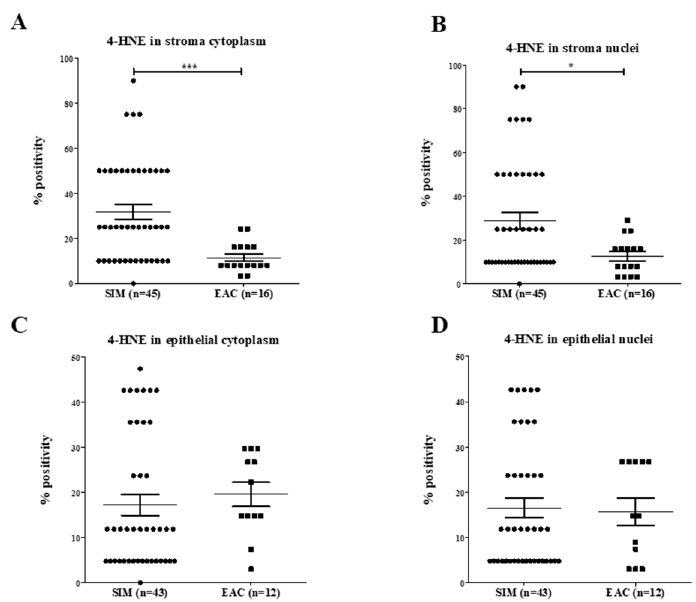
Figure 5. ( A – D ): 4-HNE percentage positivity following normalization with Ki67. There were significantly increased levels of 4-HNE in SIM stroma ( A ) cytoplasm and ( B ) nuclei compared with EAC. No di ff erences were demonstrated in 4-HNE levels in epithelial ( C ) cytoplasm ( p = 0.200) and ( D ) nuclei ( p = 0.974). * p < 0.05, *** p < 0.0005.